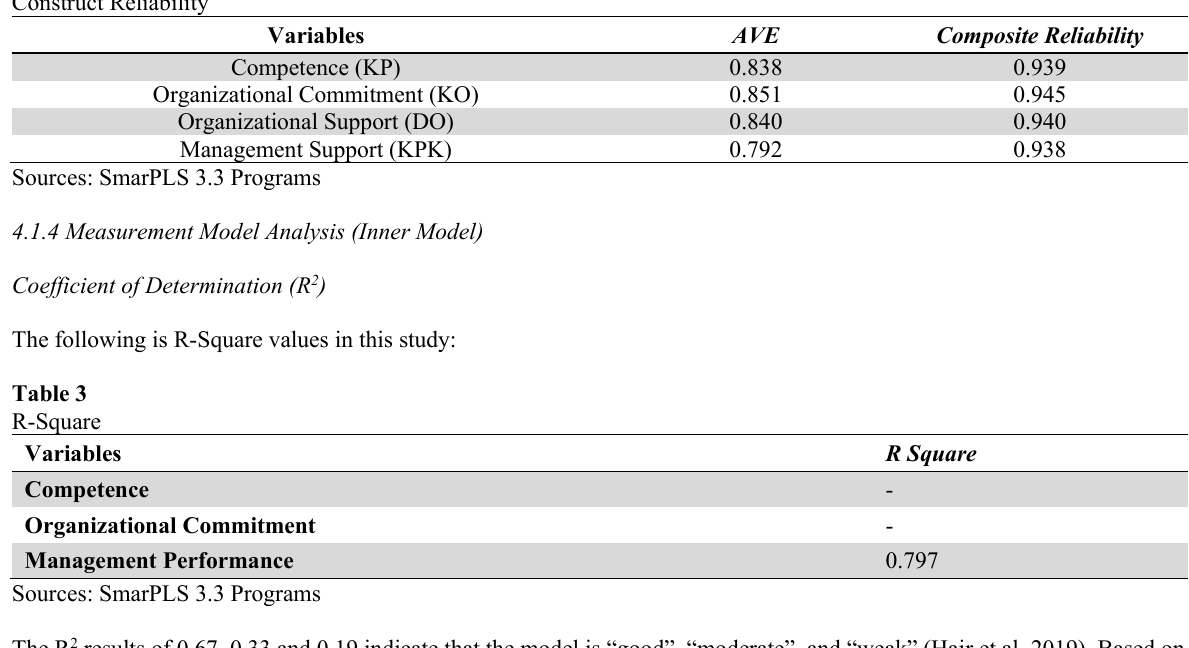
Construct Reliability